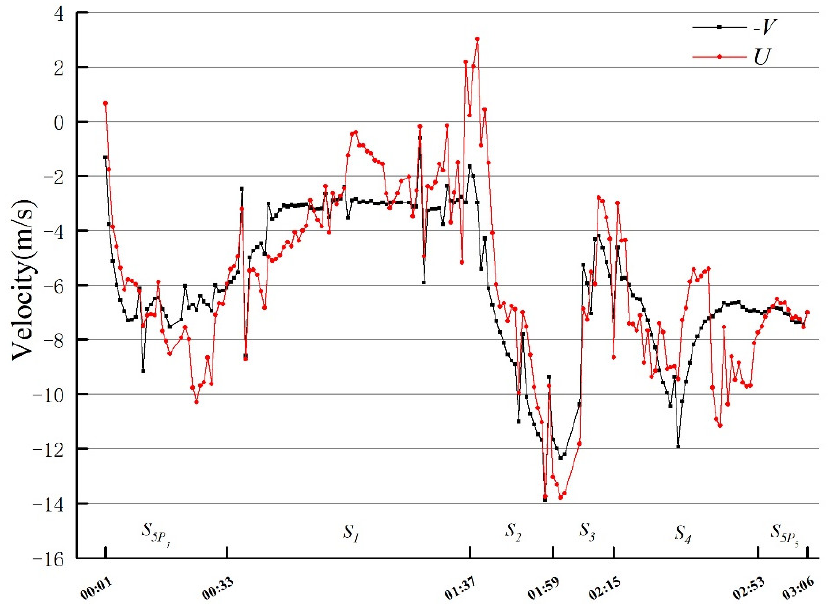
Figure 8. The relative speed between the approaching wind and the athlete’s movement ( U ) and the relative speed between the static air and the athlete’s movement ( − V ) in training case 1.